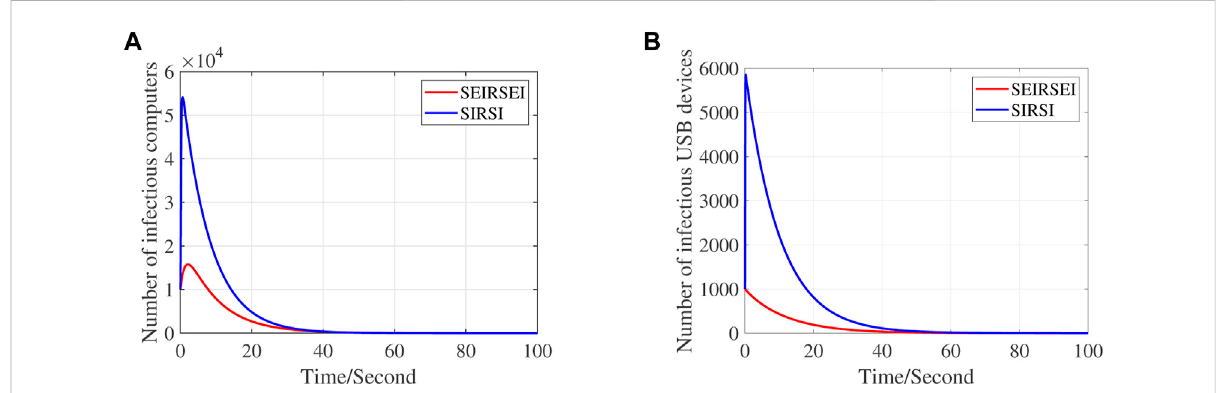
FIGURE 3 Performance comparison of the SEIRSEI model with the SIRSI model. (A) graph of infectious number of computers, (B) graph of infectious number of USB devices.